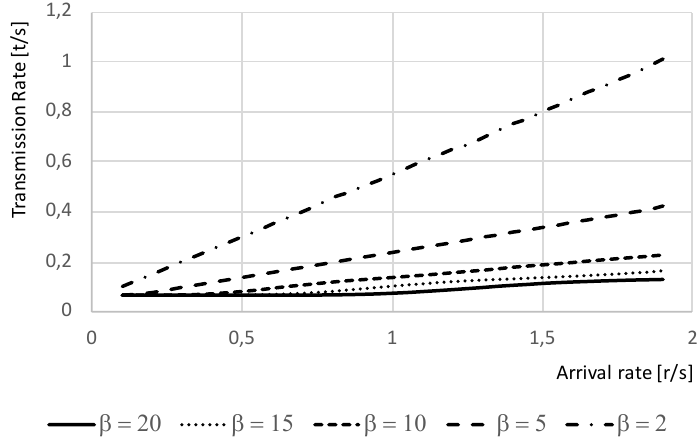
Figure 22. Batch transmissions per second vs. arrival rate of requests for various values β of the batch sizes of Urgent requests.